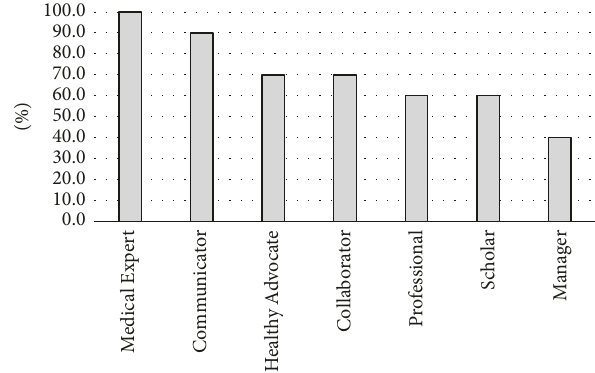
Figure 2: CanMEDs roles formally taught in the undergraduate gastroenterology